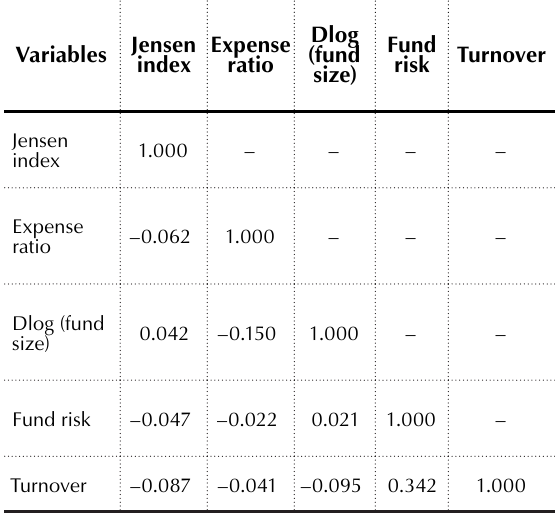
Table 5. Group A correlations